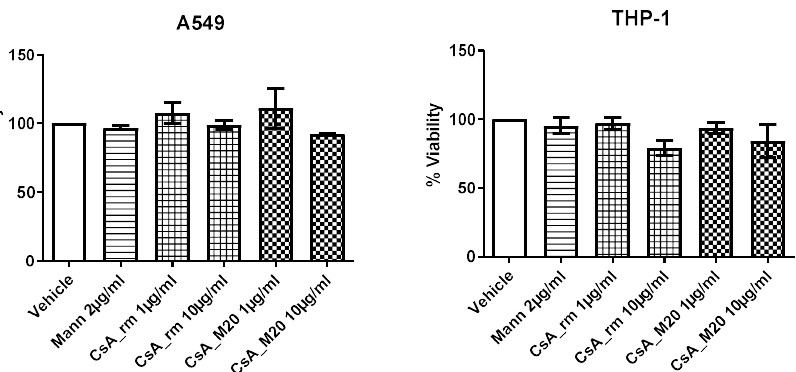
Figure 5. Viability of A549 and THP-1 cell cultures exposed to the vehicle, mannitol (Mann) 2 µg/mL, CsA_rm at 1 and 10 µg/mL, CsA_M20 spray-dried powder at of 1, and 10 µg/mL of CsA. Data are expressed as a percentage with respect to the vehicle.